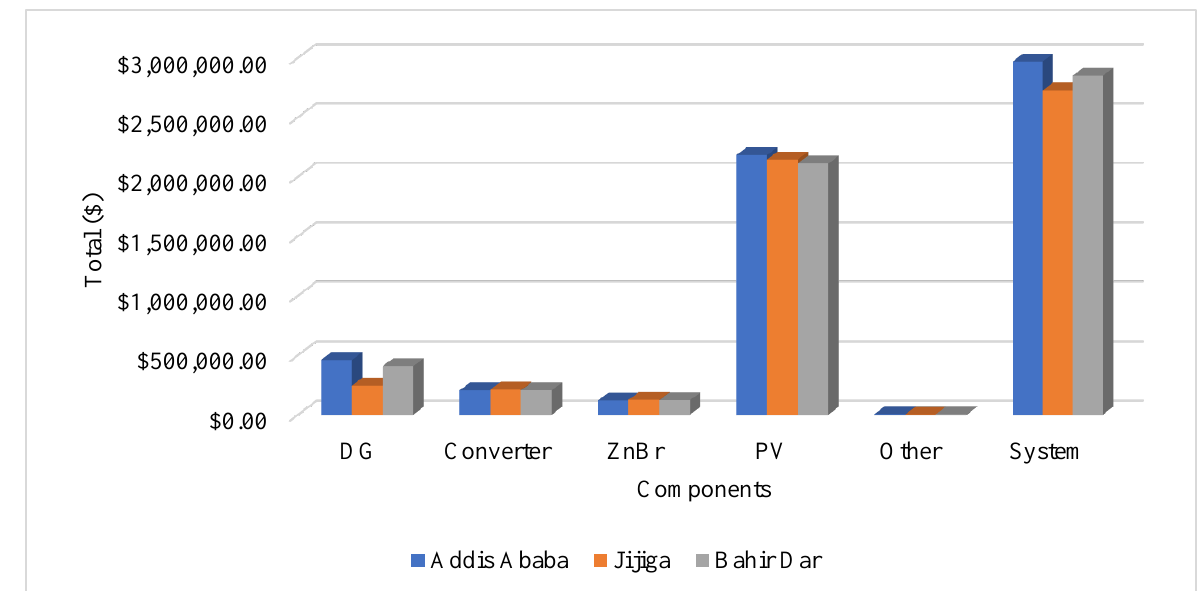
Figure 7. Total Net Present Costs (NPC) of the components of the PV/DG/ZnBr system. Considering battery technology, the optimal configuration is PV/DG/ZnBr with NPC $2.97M and COE $0.196, PV/Lead-Acid/DG with NPC $4,687,826.00 and COE $0.3089, PV/LI/DG with NPC $4,813,330.00 and COE $0.3172 in Addis Ababa. In Ji- jga it is PV/DG/ZnBr with NPC $2.72 M and COE $0.18, PV/Lead-Acid/DG with NPC $4, 460, 253.00 and COE $0.2939, PV/LI/DG with NPC $4,569,231.00 and COE $0.3011. In Bahir Dar it is PV/DG/ZnBr with NPC $2.85 M and COE $0.188, PV/Lead-Acid/DG with NPC $4,547,210.00 and COE $0.2997, PV/LI/DG with NPC $4,646,631.00 and COE $0.30.62, as shown in Figure